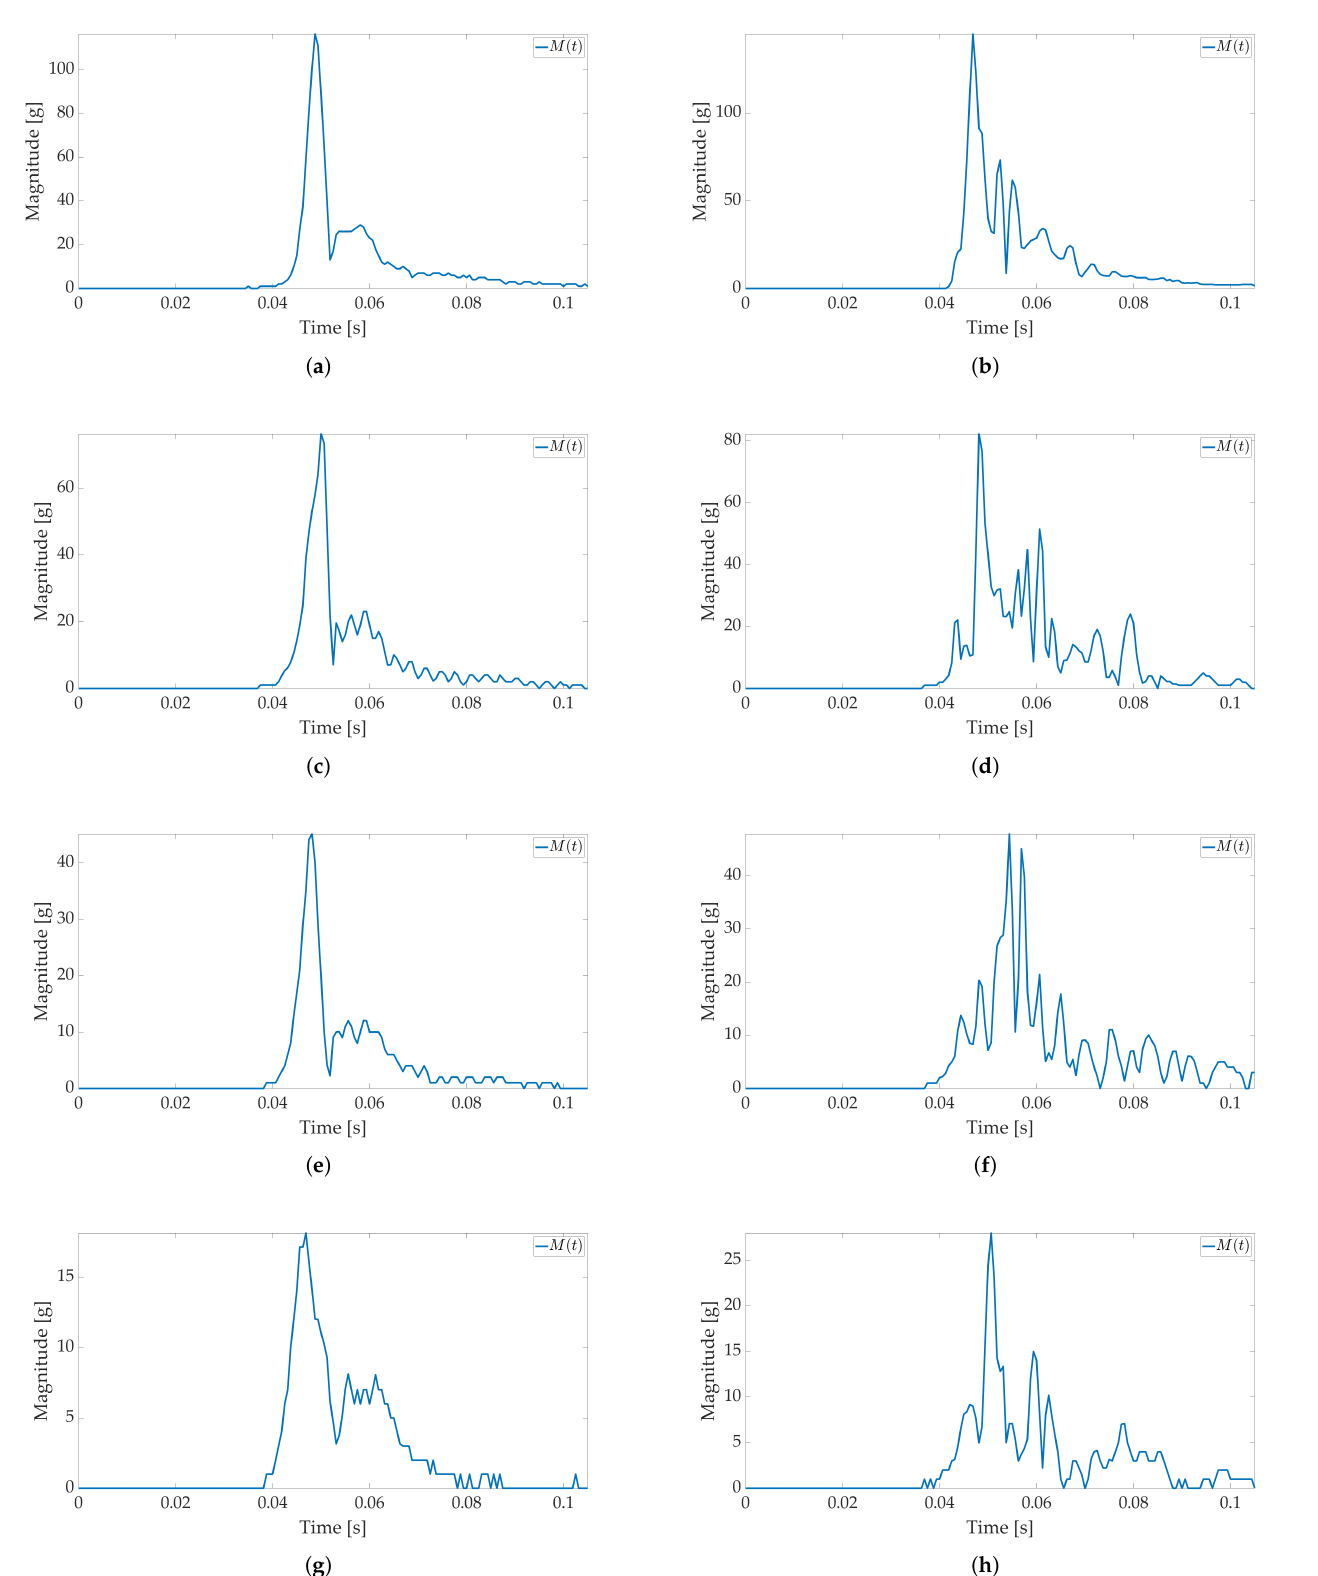
Figure 10. Shock detection values for package falling horizontally from various heights (1600 Hz with FIFO). Acceleration magnitude waveform: measured inside the package on figures ( a ) (100 cm), ( c ) (50 cm), ( e ) (20 cm), ( g ) (10 cm); measured on the package on figures ( b ) (100 cm), ( d ) (50 cm), ( f ) (20 cm), ( h ) (10